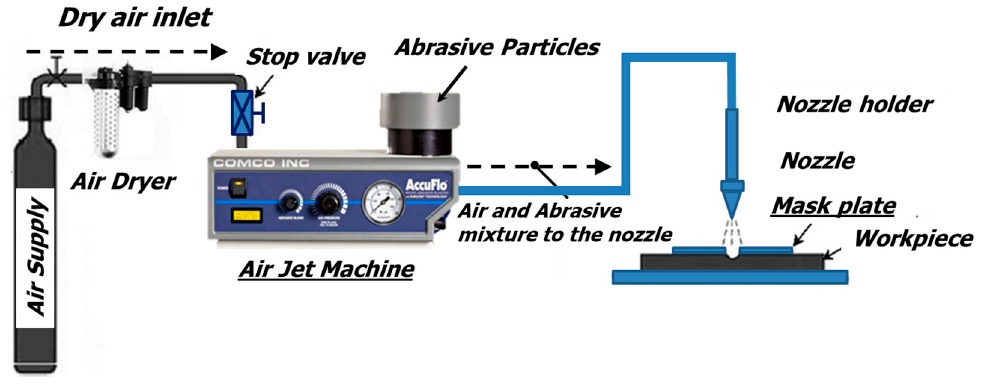
Figure 1. Typical AAJ machining system [18].